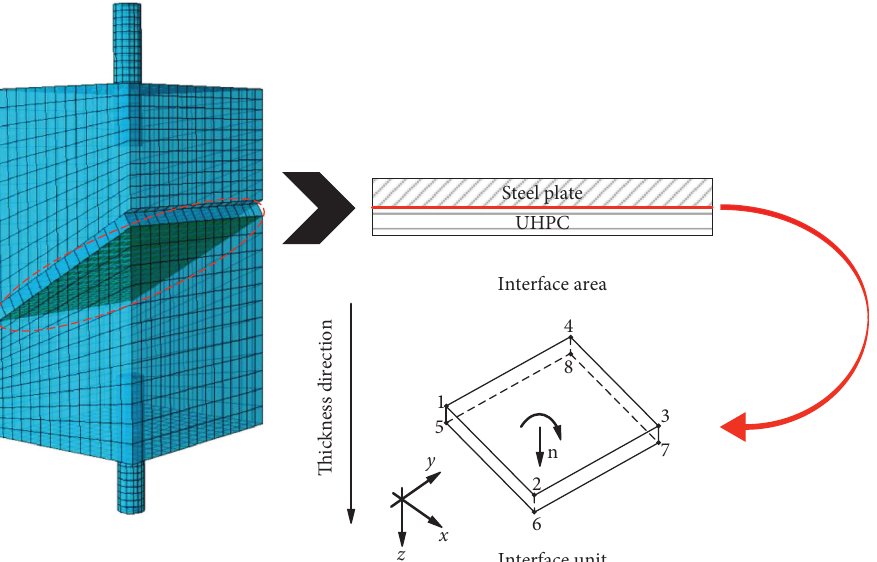
Figure 8: Zero-thickness cohesive interface element (COH3D8).